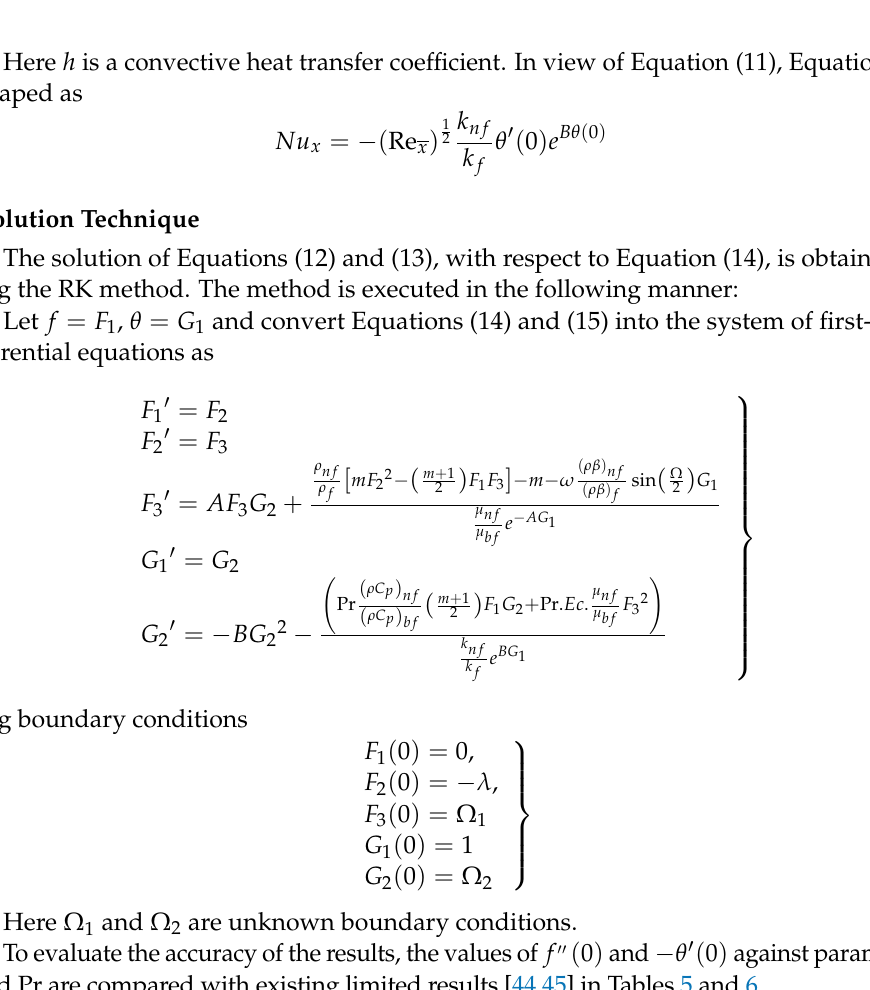
Table 5. Comparison of results for f (cid:48)(cid:48) ( 0 ) with numerical results in [44] when φ = 0 and n = 1. β